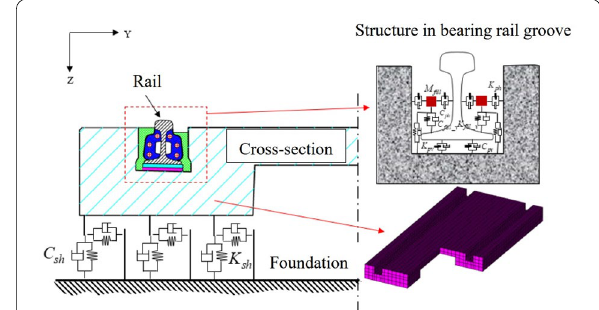
Figure 3 Schematic of embedded track dynamic model